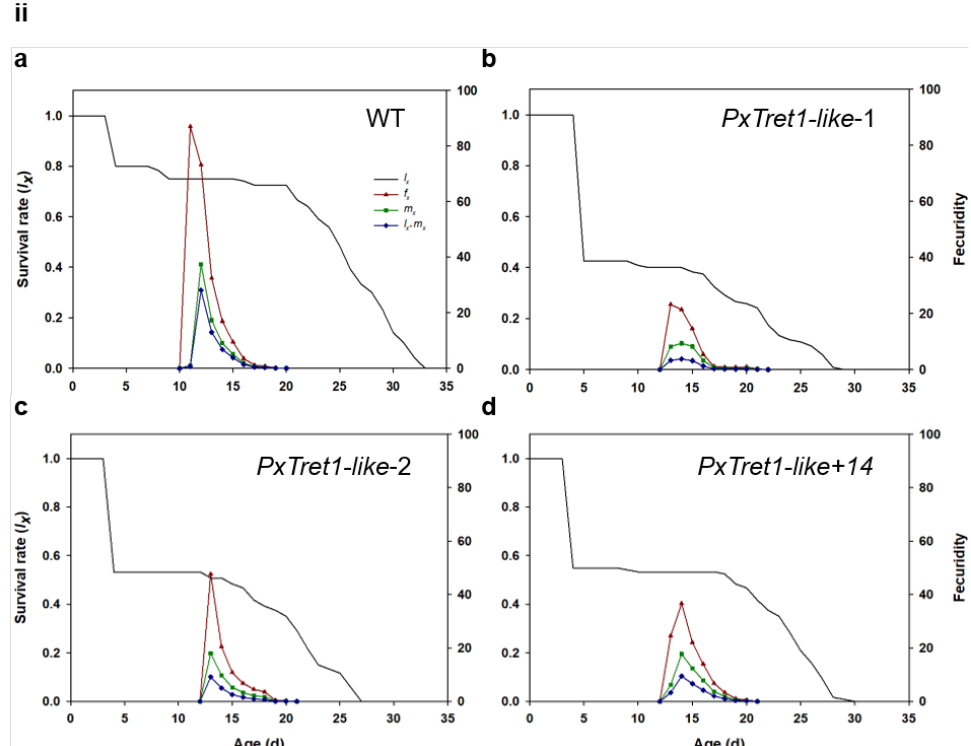
Figure 7. Effects of PxTret1-like knockout on age-stage characteristics of Plutella xylostella . ( i ) Age-stage survival rates ( S xj ) of Plutella xylostella in different strains and in different generations; ( ii ) age-specific survival rates ( l x ), female age-stage specific fecundity ( f x j ) and age-specific fecundity of total population ( m x ) of Plutella xylostella in different strains and in different generations. ( a ): wild-type strain; ( b – d ): mutant of PxTret1-like .